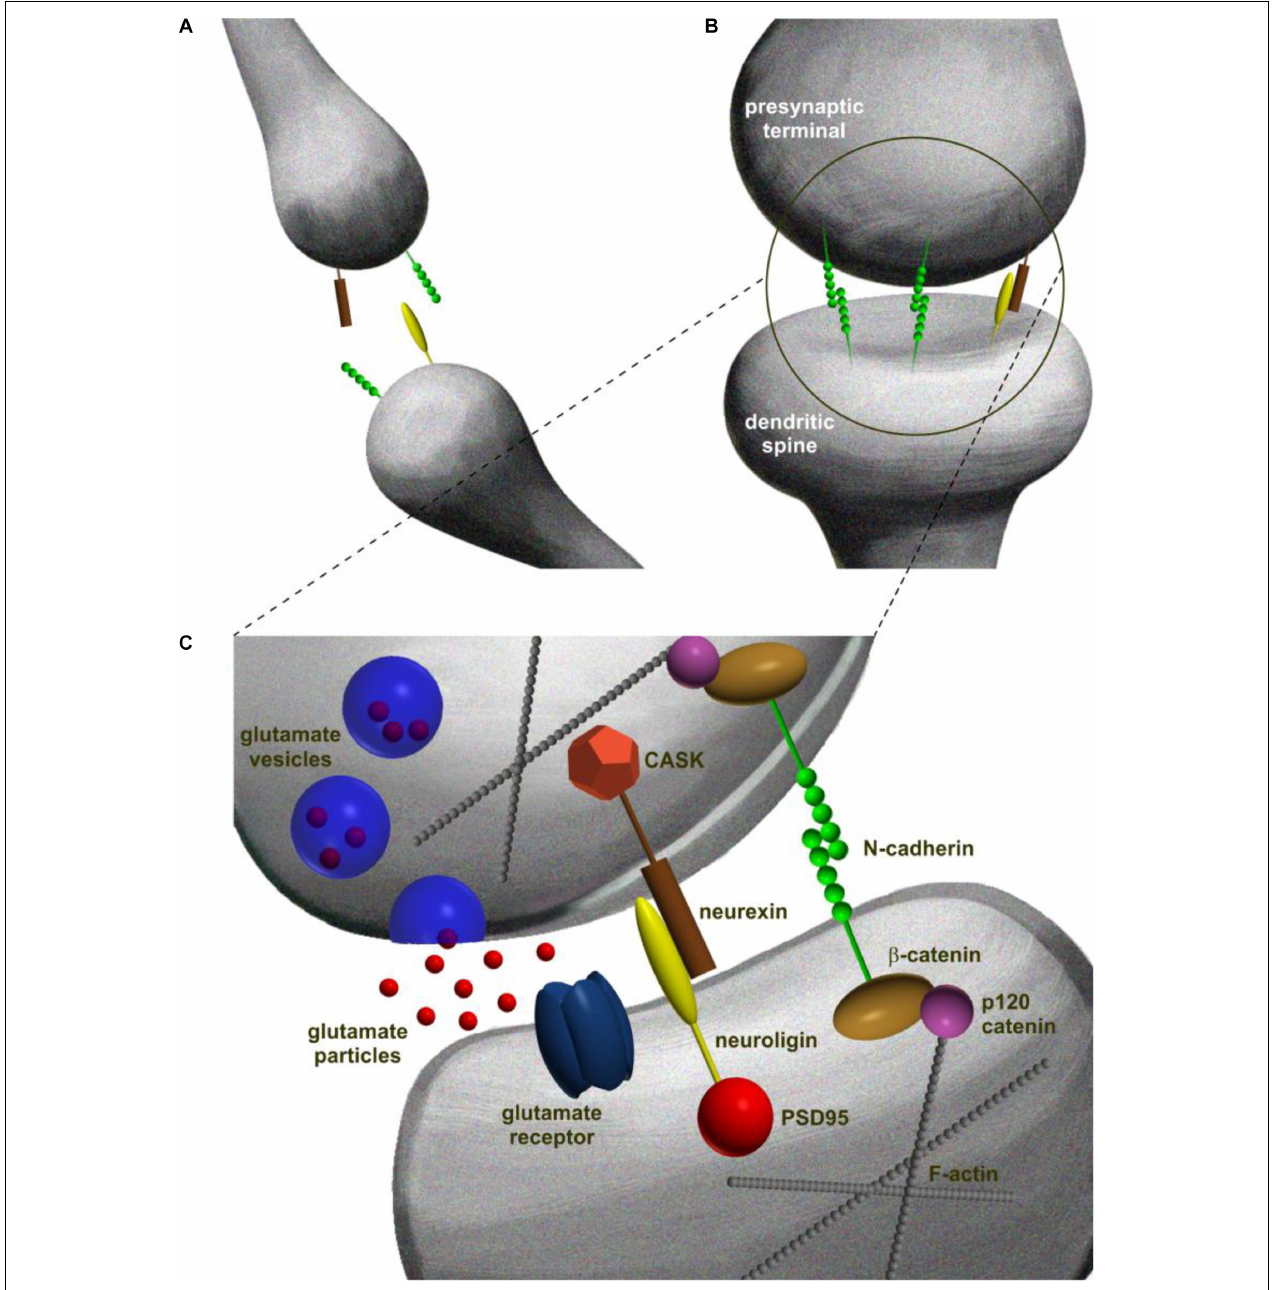
FIGURE 2 | Schematic representation of different steps in trans-synaptic complex formation in excitatory synapse development. (A) Synaptogenesis is initiated at the points of contacts between dendritic filopodia and axons. At this stage, synaptic CAMs are distributed evenly at the contact point. (B) Contact point is stabilized by dimerization of the opposing CAM molecules that form trans-synaptic complexes spanning the partner cells and creating mechanical adhesion points. (C) Adhesion points develop into mature synapses that consist of presynaptic terminal with neurotransmitter vesicles and a postsynaptic density characterized by the presence of receptors. The molecular diversity of pre- and postsynaptic constituents is built upon C-terminal interactions of trans-synaptic complexes linking the trans-synaptic dimer to the scaffolding proteins and filamentous actin (McMahon and Díaz,